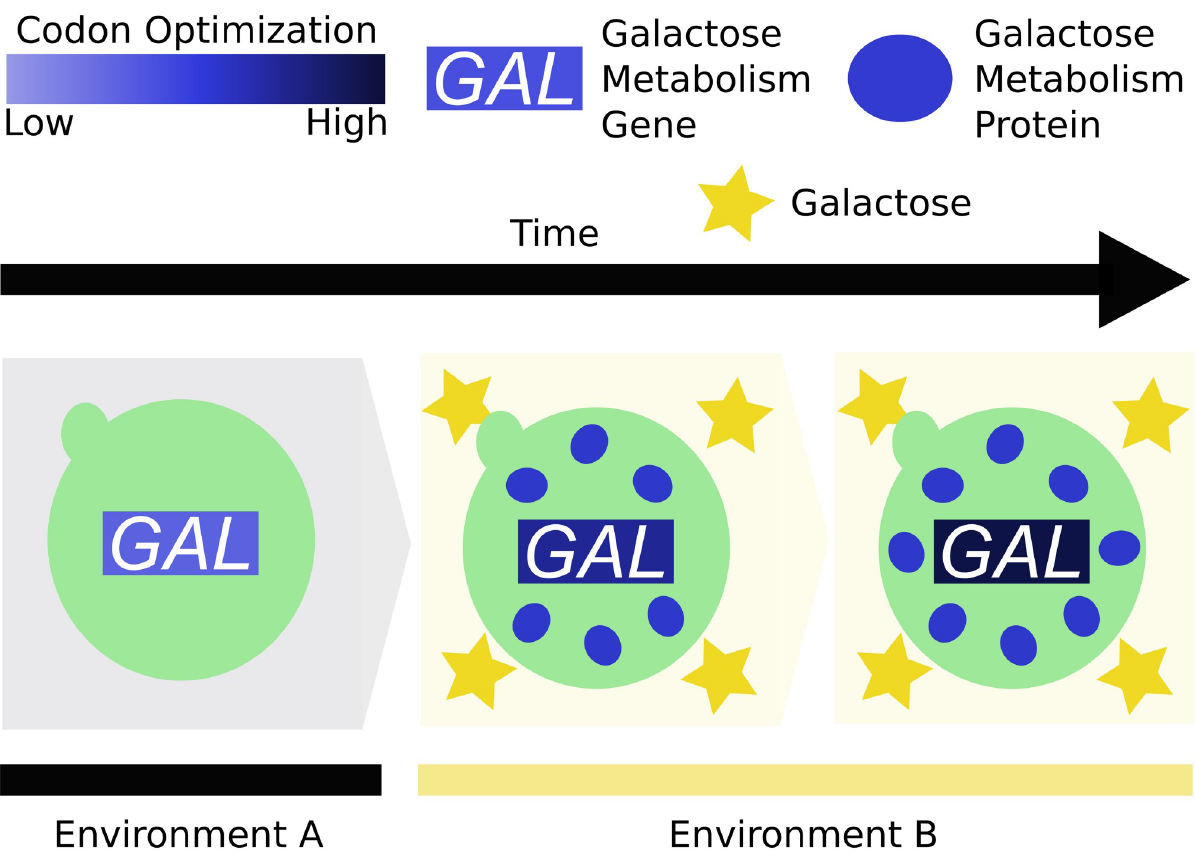
Fig 5. A model for ecological codon adaptation in the GAL actose metabolism pathway. The ancestral species in environment A maintains the GAL actose metabolism pathway at an intermediate codon optimization. Upon introduction to environment B, which contains abundant galactose, there is increased demand for the GAL actose metabolism enzymes to take advantage of this energy source. In this new environment, substitutions that increase codon optimization of the GAL genes will be selectively advantageous. Codon optimization will continue to increase under translational selection until it is no longer a barrier to expression or optimal flux through the pathway has been